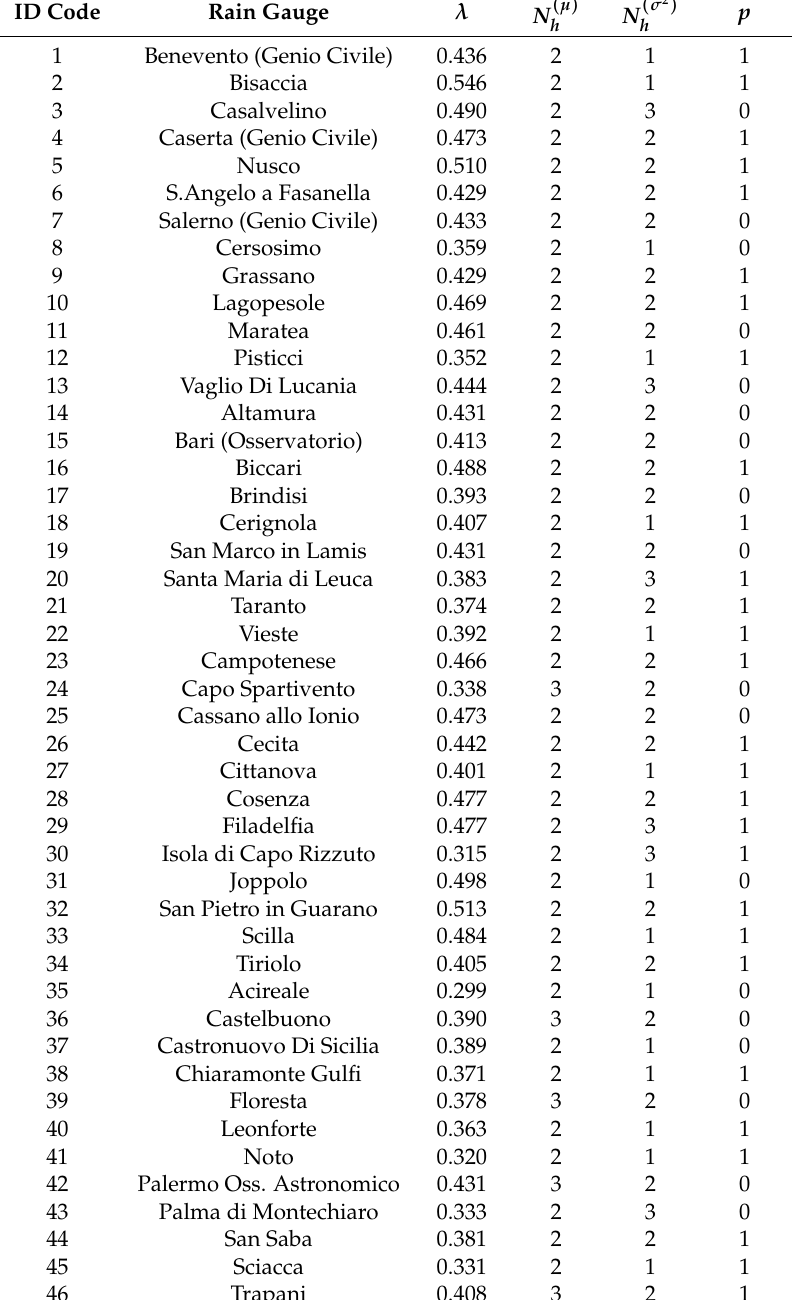
Table 3. Values of the transformation parameter λ , number of harmonics N and the variance functions, respectively, and p -order of the autoregressive model, estimated for each rain